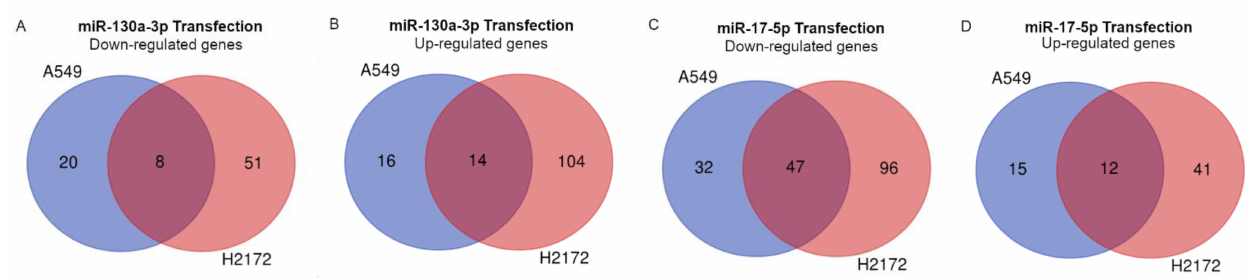
Figure 7. Venn Graphs show the deregulated genes shared by two cells after the transfections with miR-130a-3p ( A , B ) and miR-17-5p ( C , D